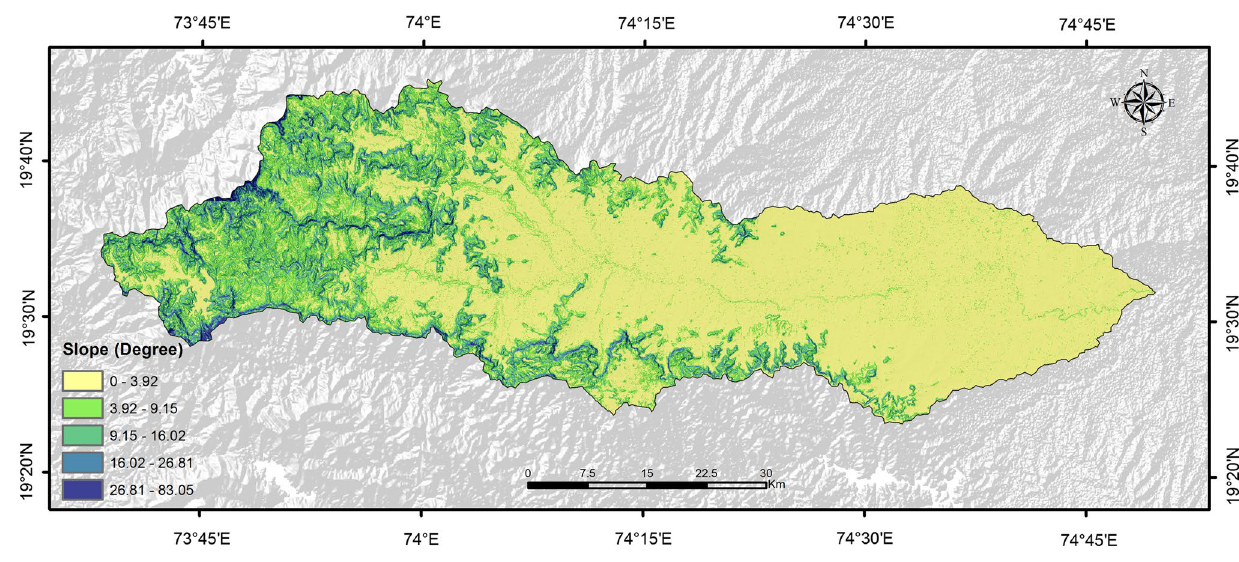
Fig. 7 Slope map of the study area